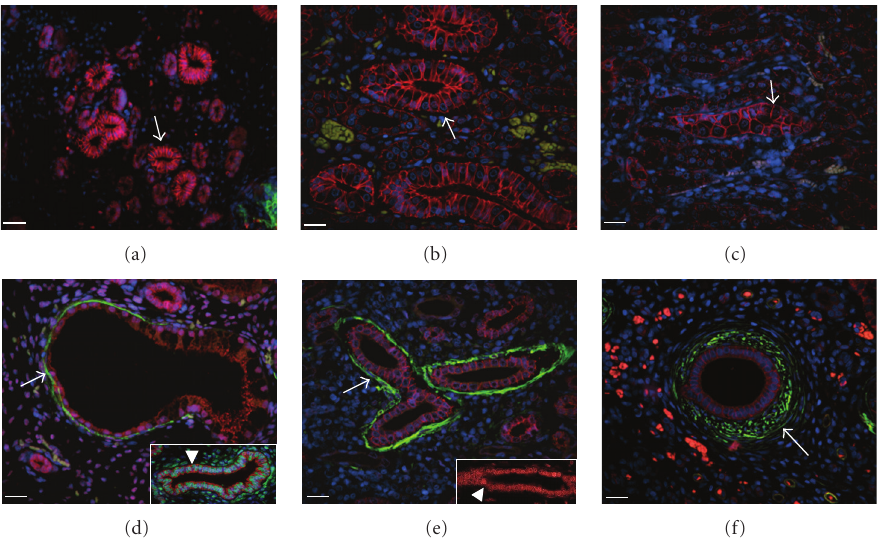
Figure 4: E-cadherin and α -smooth muscle actin immunoreactivity . Normal kidneys ((a)–(c)). In the normal mid gestation (18 weeks) (a), late gestation (27 weeks) (b), and postnatal (12 months) (c) kidneys, α -smooth muscle actin ( α -SMA)-IR (green) was absent in the CD epithelium; however, intercellular localization of E-cadherin-IR (red) was well established from mid gestation onwards (arrows). Obstructed kidneys ((d)–(f)). Circumferential collars expressing α -SMA-IR (green) are present in the (d) mid gestation (18 weeks), (e) late gestation (36 weeks), and (f) postnatal (16 months) kidneys (arrows). De novo expression of α -SMA-IR in the obstructed CD epithelium is present at 18 weeks gestation ((d) inset, arrowhead) but not in the late gestation (e) or postnatal (f) kidneys. As in Figure 3, E-cadherin expression (red) is disrupted, with translocation from the cell membrane to cytoplasm ((d)–(f)) and to the nucleus ((e) inset, arrowhead). Scale bar = 25 μ m.